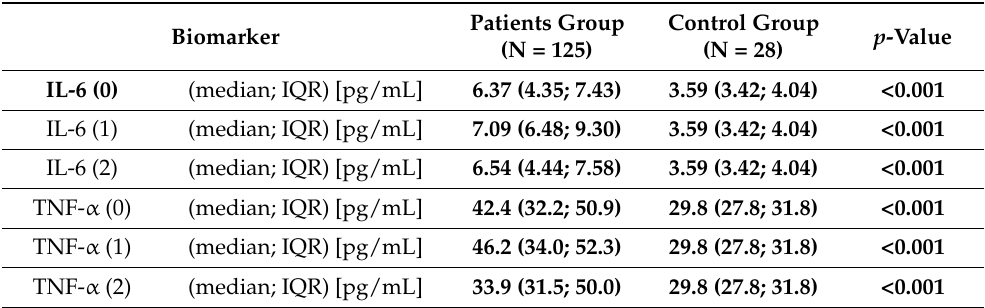
Table 3. The value of biomarker concentrations at various time intervals in comparison with the control group.